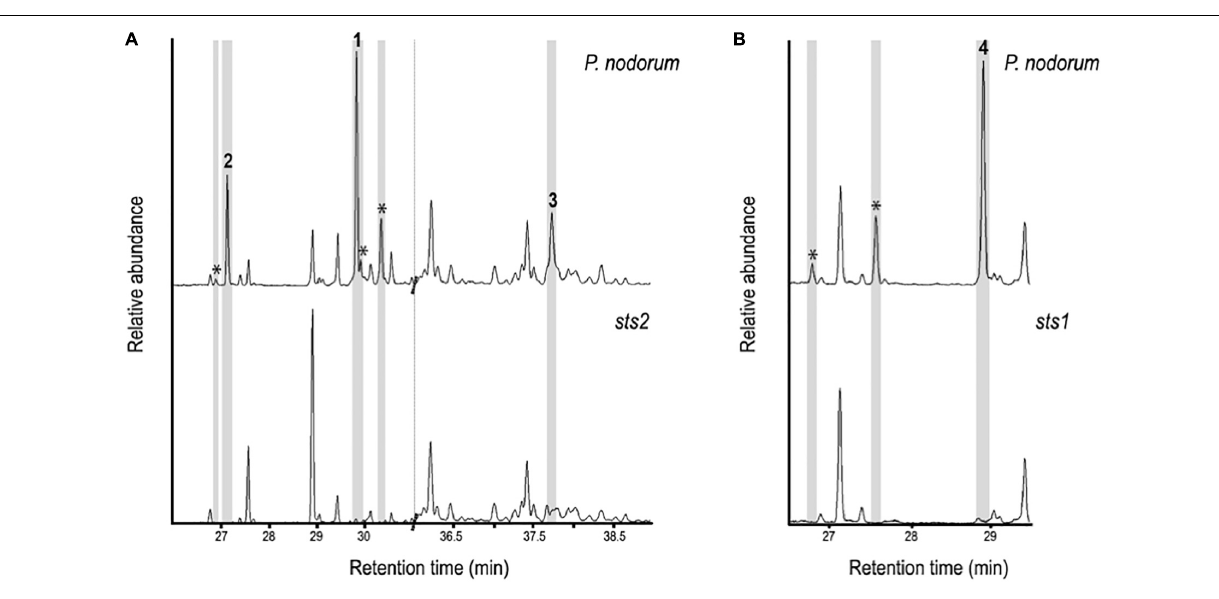
( Figure 6 ) based on comparison to previously reported NMR data (Iwabuchi et al., 1989; Chen and Lin,